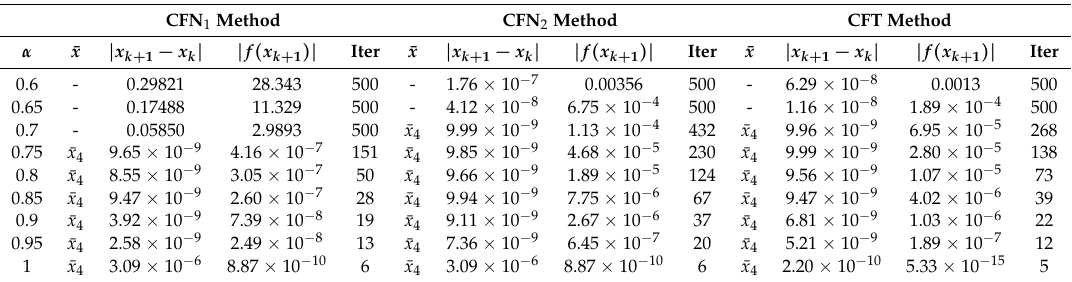
Table 1. Results of fractional Newton and Traub-type methods for f 1 ( x ) with Caputo derivative and initial estimation x 0 = −